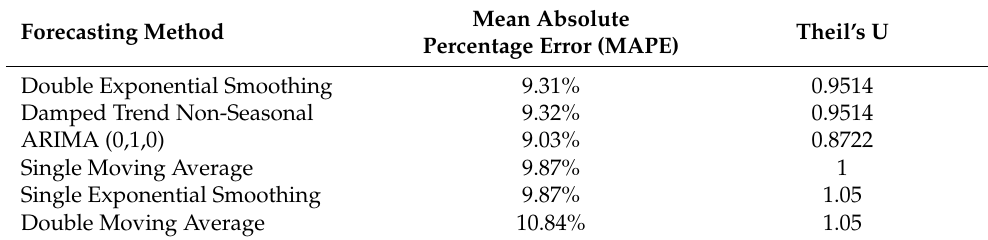
Table 2. Evaluation of each forecasting method considering different statistical parameters. Forecasting Method